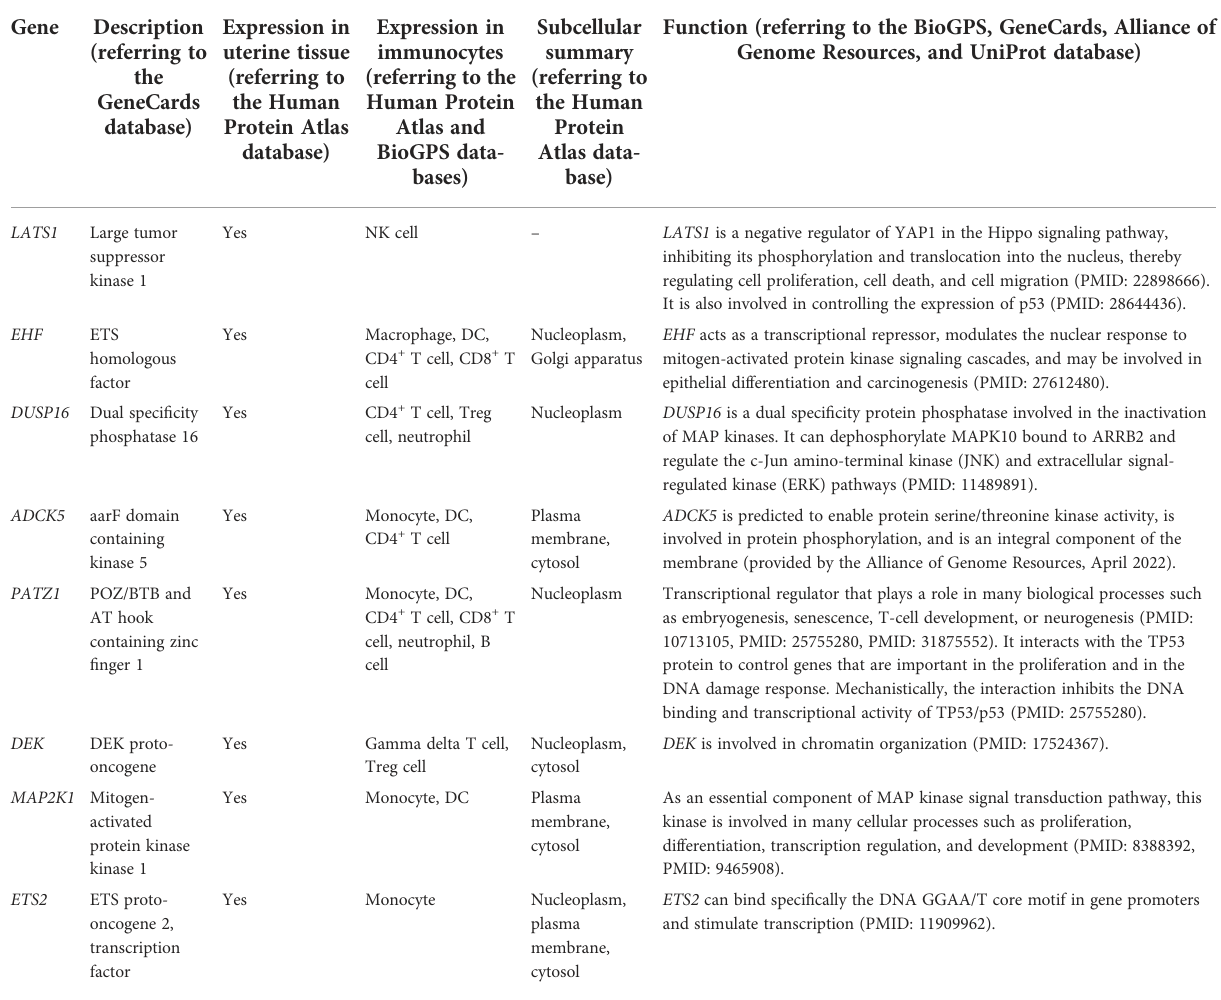
TABLE 2 Immune localization of RIF signature